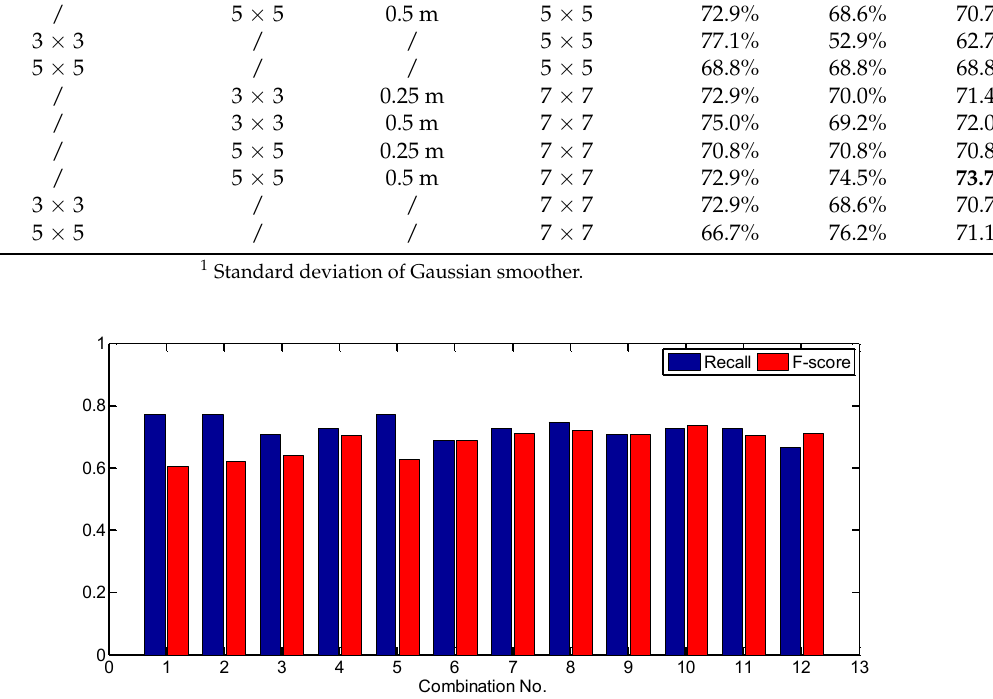
Figure 8. The effects caused by changing LM extraction-related parameter values on test site 1. The parameter values for each combination can be found in Table 2. MaxD = 1.5 m, significance level = 0.10, and score threshold =